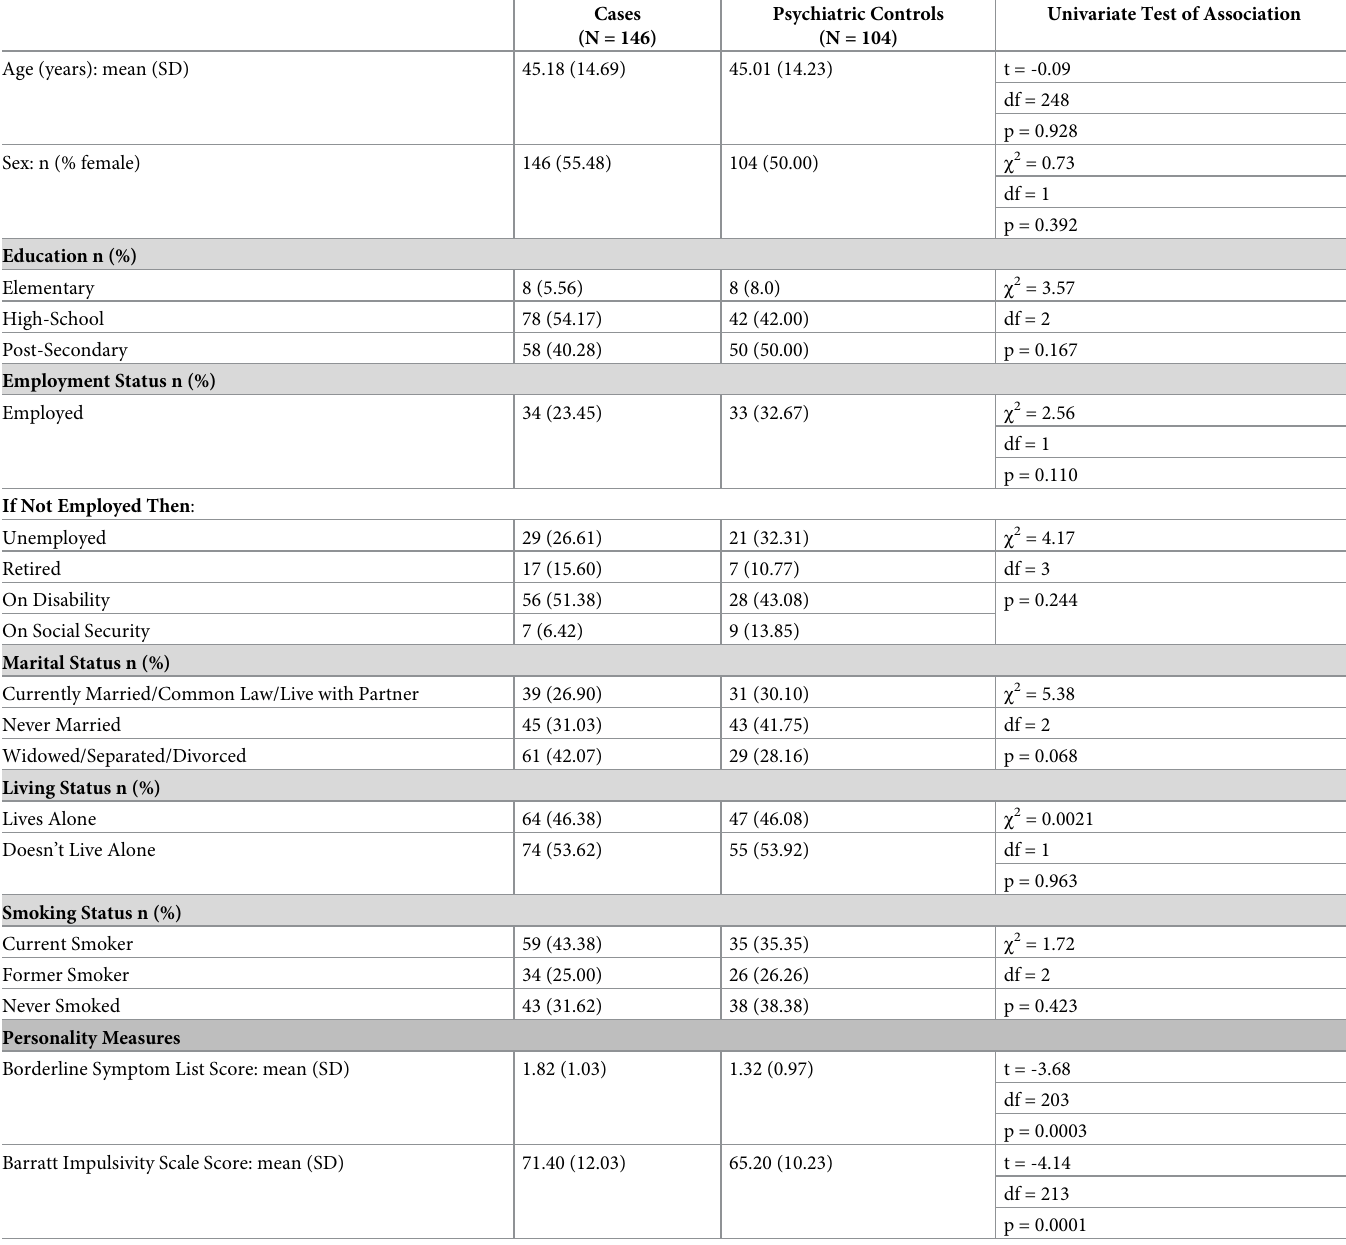
Table 1. Study sample